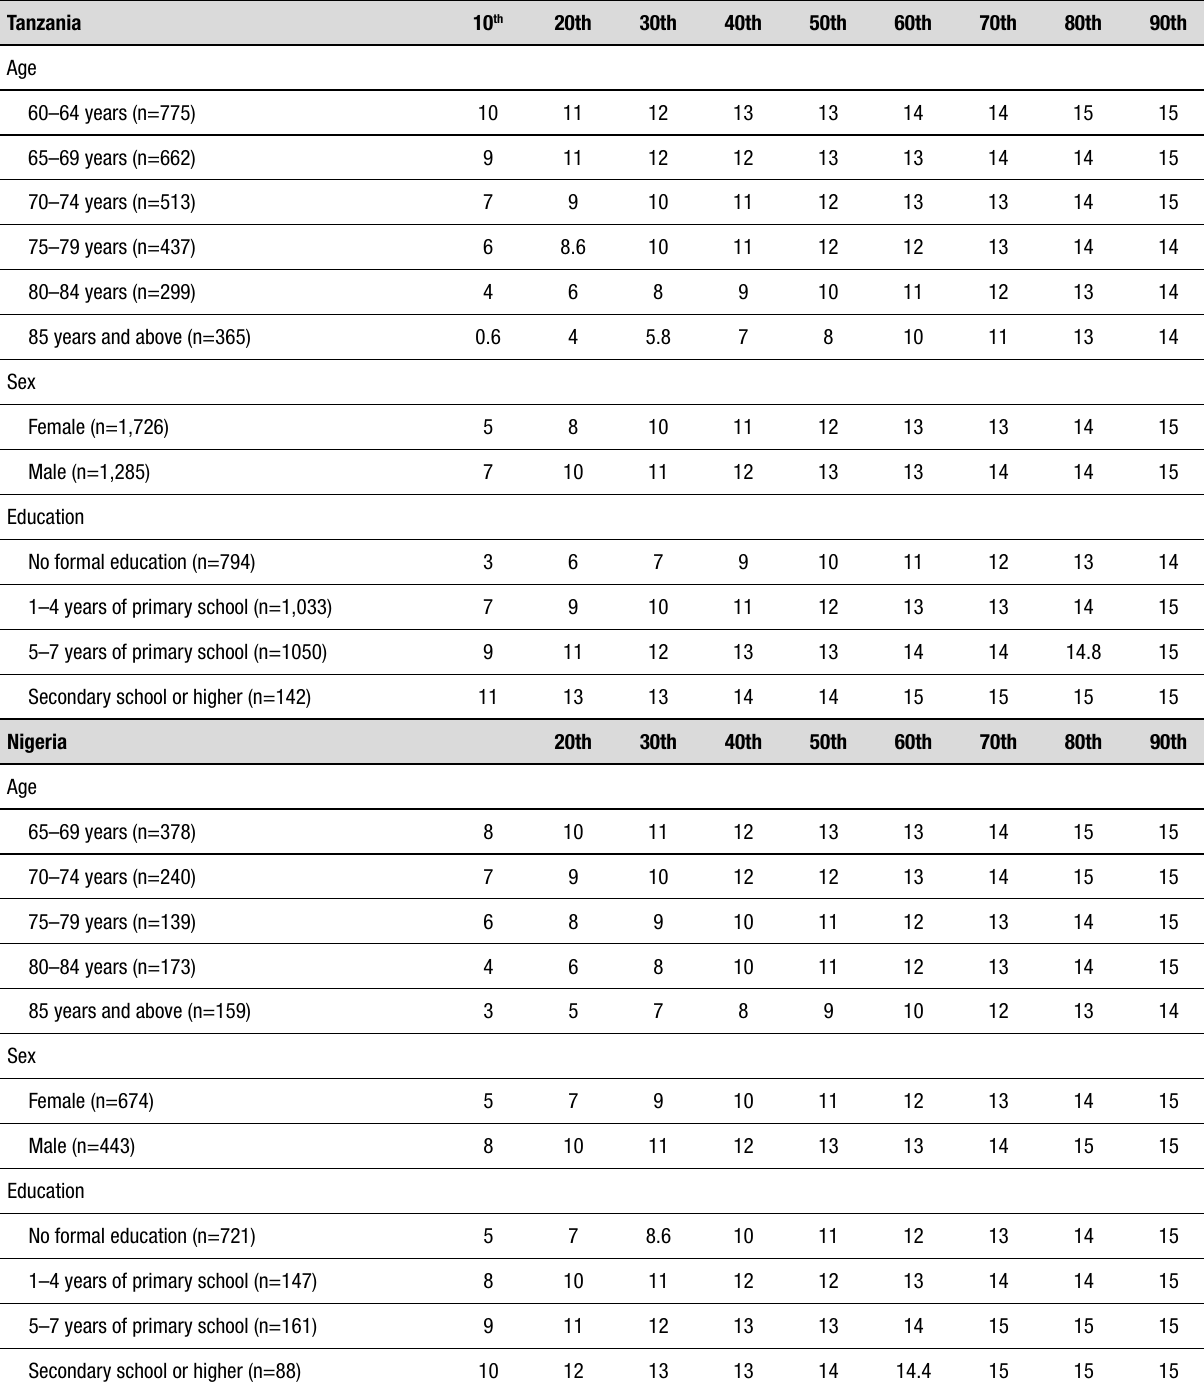
Table 1. Deciles for the total Identification of Dementia in Elderly Africans cognitive screen score by the categories of age, sex, and education in Tanzania and